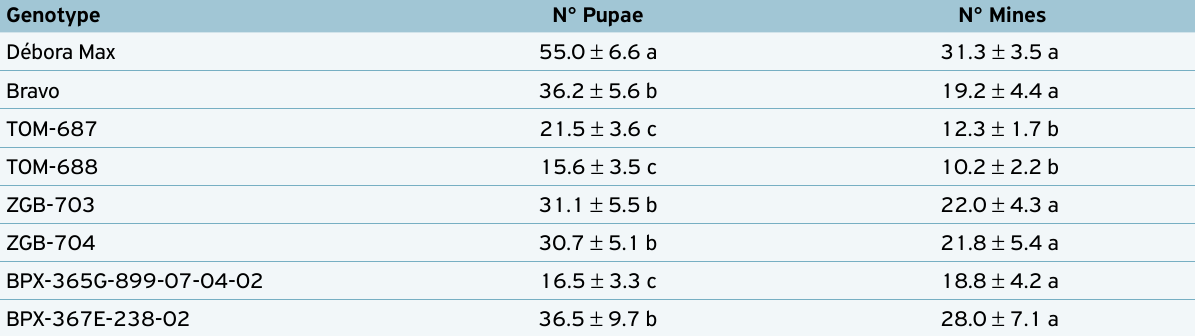
Means followed by the same letter do not differ statistically from each other by the Scott & Knott test ( p ≤